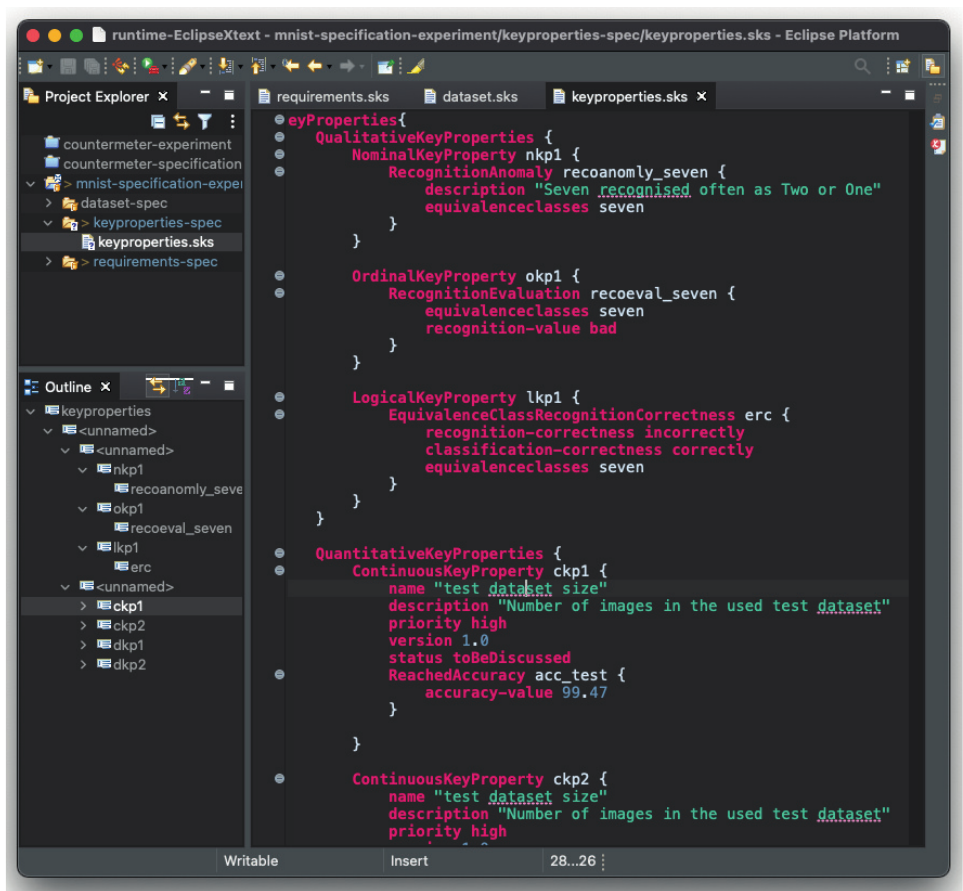
Figure 11. SEMKIS-DSL tool support [5] with sample key-properties